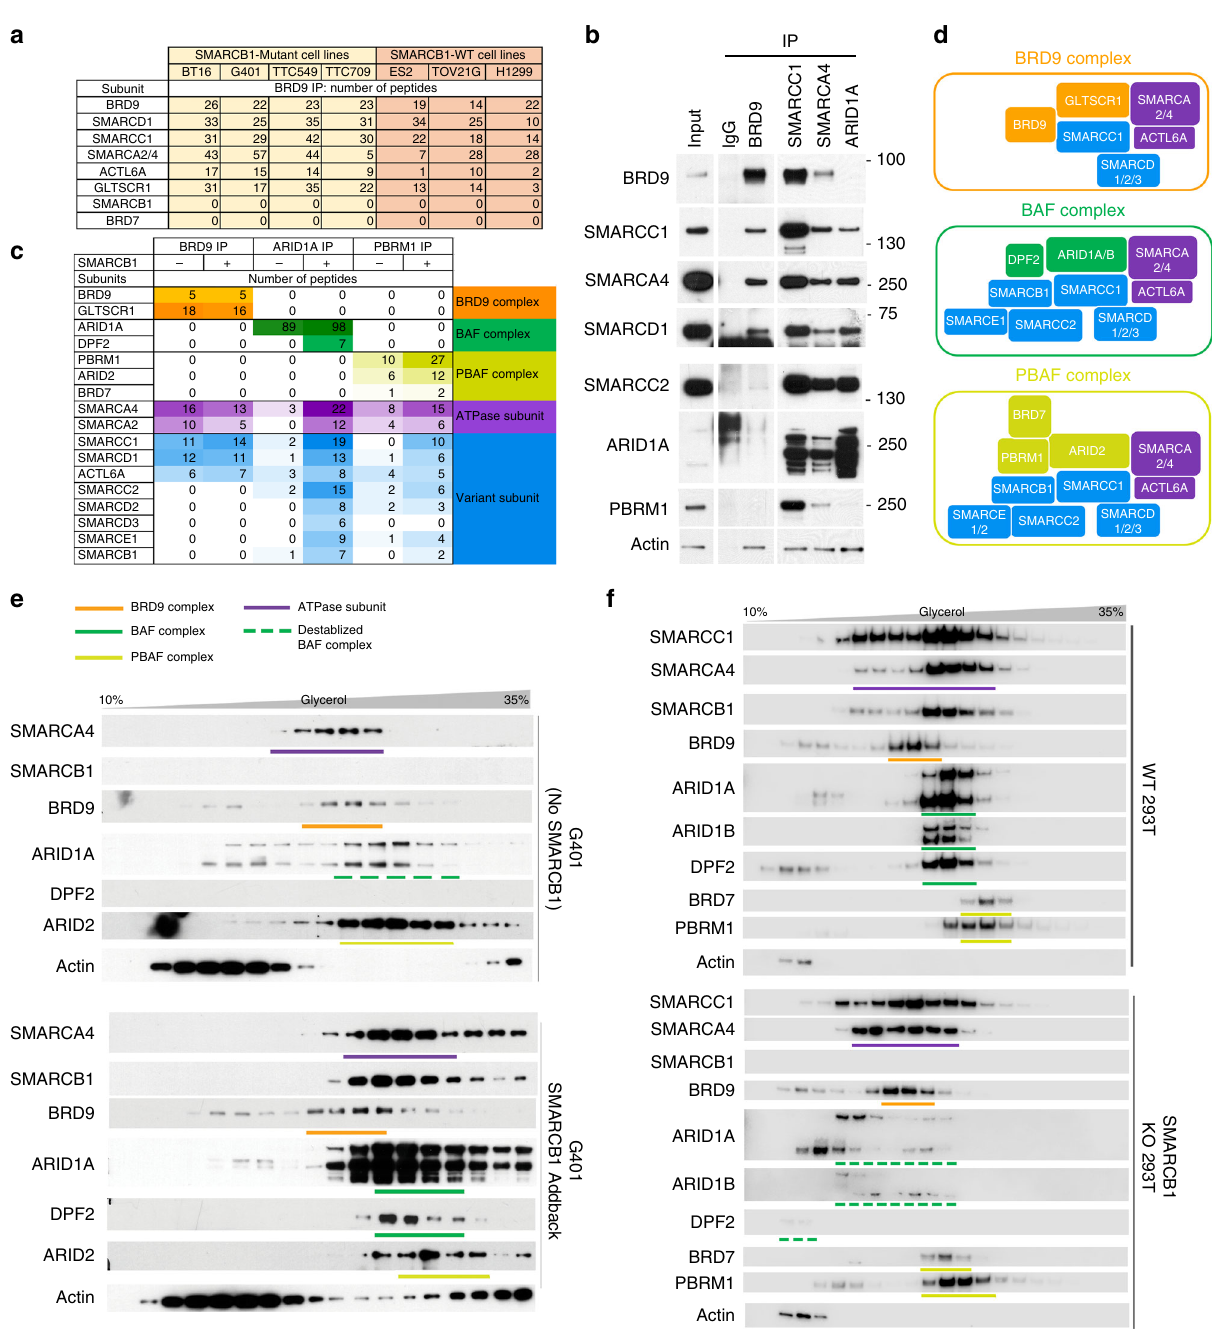
Fig. 2 BRD9 de fi nes a unique SWI/SNF subcomplex. a Immunoprecipitation-mass spectrometry of BRD9 showing known SWI/SNF subunits from four RT ( SMARCB1 -Mutant) cell lines and three non-RT ( SMARCB1 -WT) cell lines. Source data are provided as a Source Data fi le. b Immunoprecipitation of BRD9 in RT cell line G401 cells and blotted with indicated SWI/SNF subunits. c Immunoprecipitation-mass spectrometry of BRD9, ARID1A, PBRM1 in RT cell line G401 without or with SMARCB1 re-expression, showing differential IP enrichment of BRD9, BAF, and PBAF complex subunits. d Model of BRD9-SWI/SNF subcomplex in comparison to BAF and PBAF complexes, color for each subunit is consistent with what described in Fig. 2c. e , f Glycerol gradient of SWI/ SNF complexes in G401 cells without (top half) or with SMARCB1 addback (bottom half) ( e ); or in HEK293T parental (top half) or isogenic SMARCB1 KO cells (bottom half) ( f ). BRD9 complexes are slightly smaller than BAF and PBAF complexes and there is a shift of core subunits (SMARCC1, SMARCA4) from BAF complexes to BRD9 complexes in the absence of